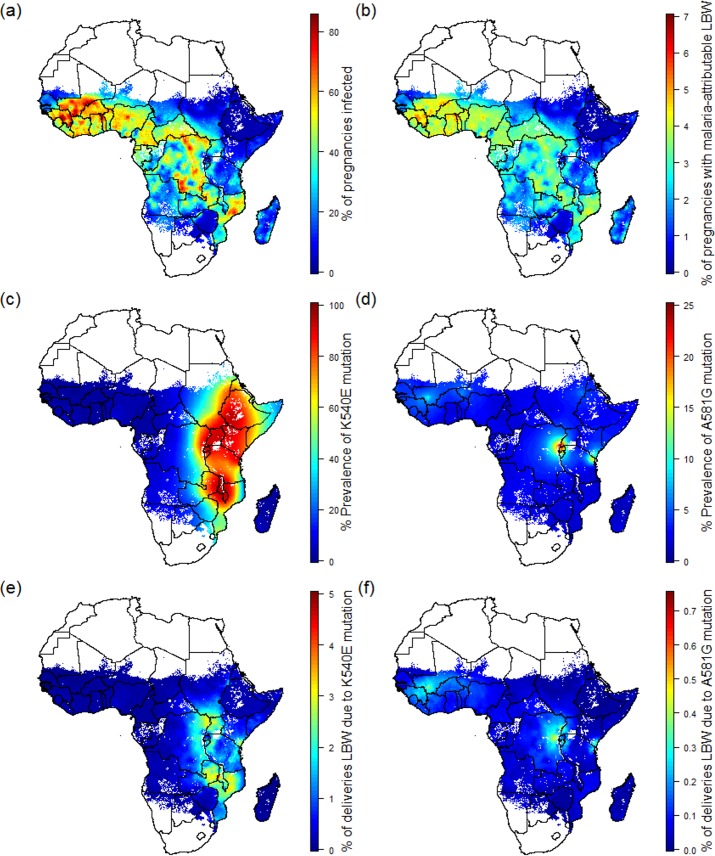
Preventable malaria burden and sulphadoxine-pyrimethamine resistance.(A) Percent of pregnancies infected in the absence of intervention in 2015. (B) Percent of pregnancies leading to malaria-attributable LBW in 2015 in the absence of intervention. (C) Prevalence of the quintuple K540E mutation within infected individuals. (D) Prevalence of the sextuple A581G mutation within infected individuals. (E) Percent of pregnancies leading to malaria-attributable LBW due to infection involving the quintuple mutation. (F) Percent of pregnancies leading to malaria-attributable LBW due to infection involving the sextuple mutation. LBW, low birthweight.